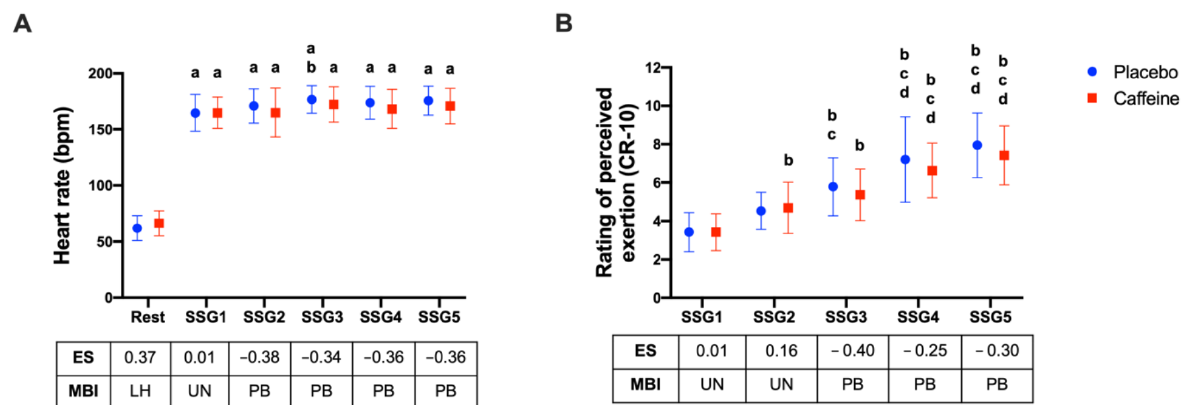
Figure 2. ( A ) Heart rate at rest and after five SSG; ( B ) rating of perceived exertion after five